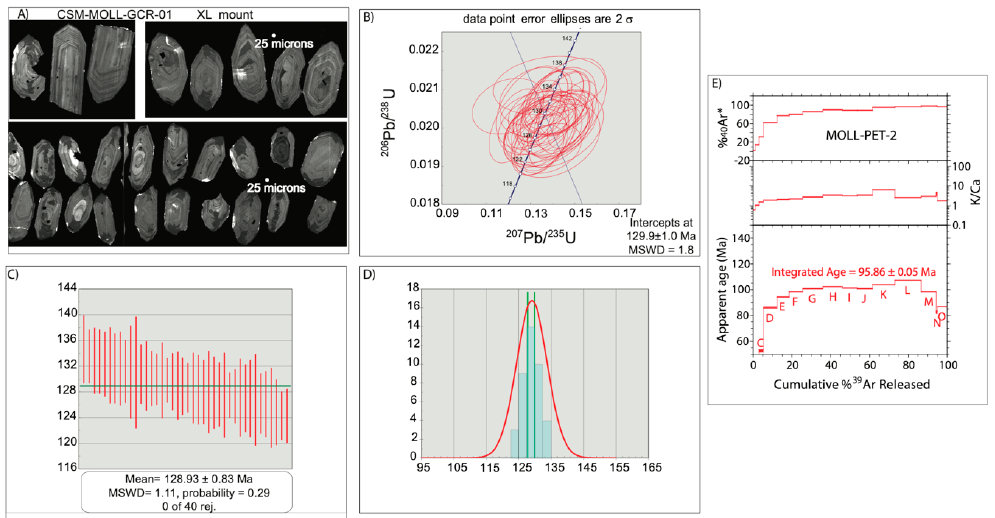
Figure 13. Geochronology. U-Pb age determination in zircon from wall rock hosting veins at Mollehuaca and 40 Ar / 39 Ar age of secondary biotite alteration. ( A ) Cathodoluminescence microscopy images; ( B ) Tera-Wasserburg plot; ( C ) Frequency histogram; ( D ) Probability density plot and ( E ) Incremental 40 Ar/ 39 Ar release patterns of secondary biotite sample . In all panels, errors are considered at 2 σ level. rej.: rejected.